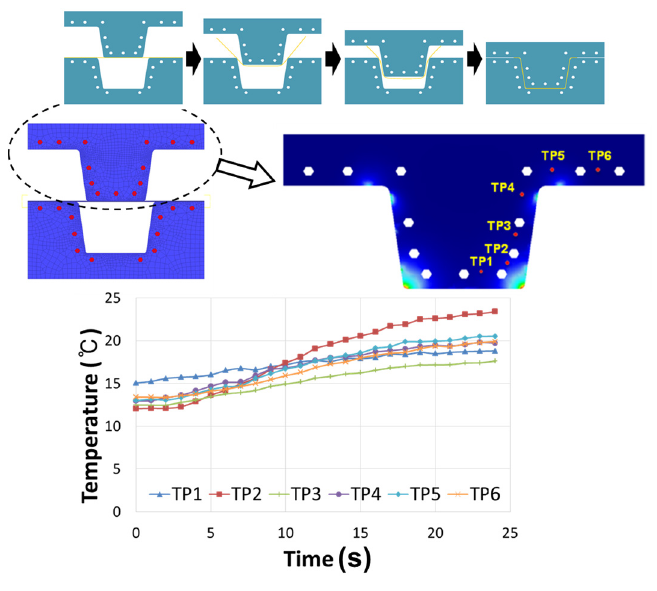
Figure 4. Temperature data measured at six points (TP1–TP6) on the upper die (punch) during forming at the speed of 3.0